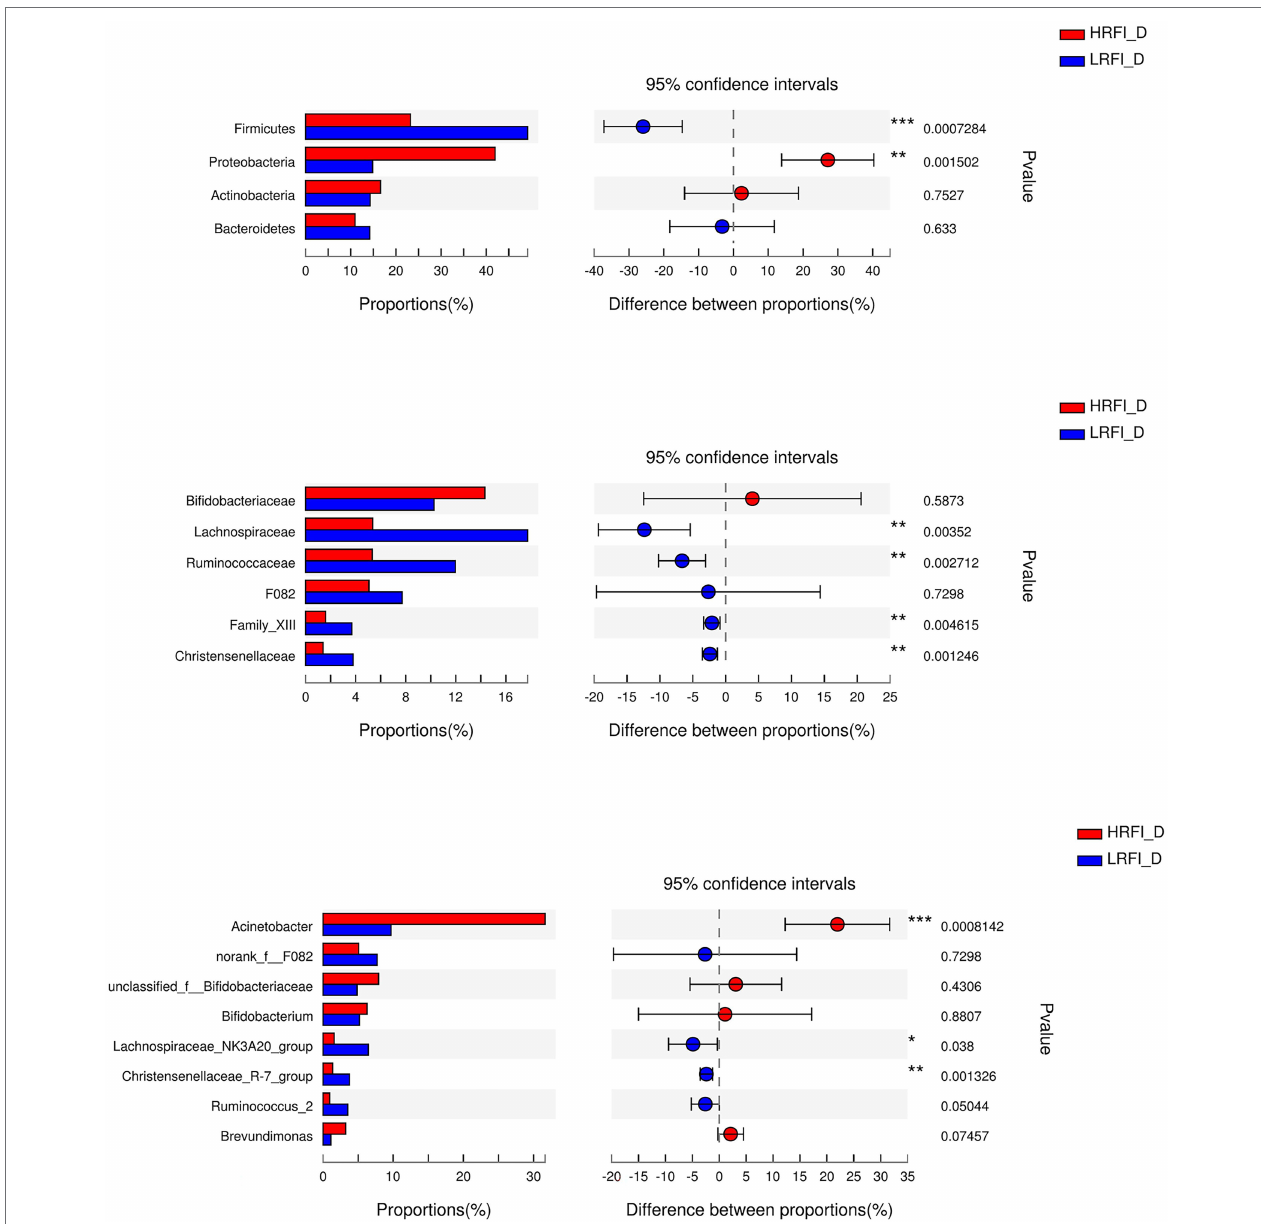
FIGURE 5 | Significantly differential abundant phyla, families, and genera (relative abundance >1%) with the duodenum bacteria. Positive and negative differences indicate a greater abundance in the HRFI group and LRFI group, respectively. *Represents 0.01 < p < 0.05; ** represents 0.001 < p < 0.01; and *** represents p <